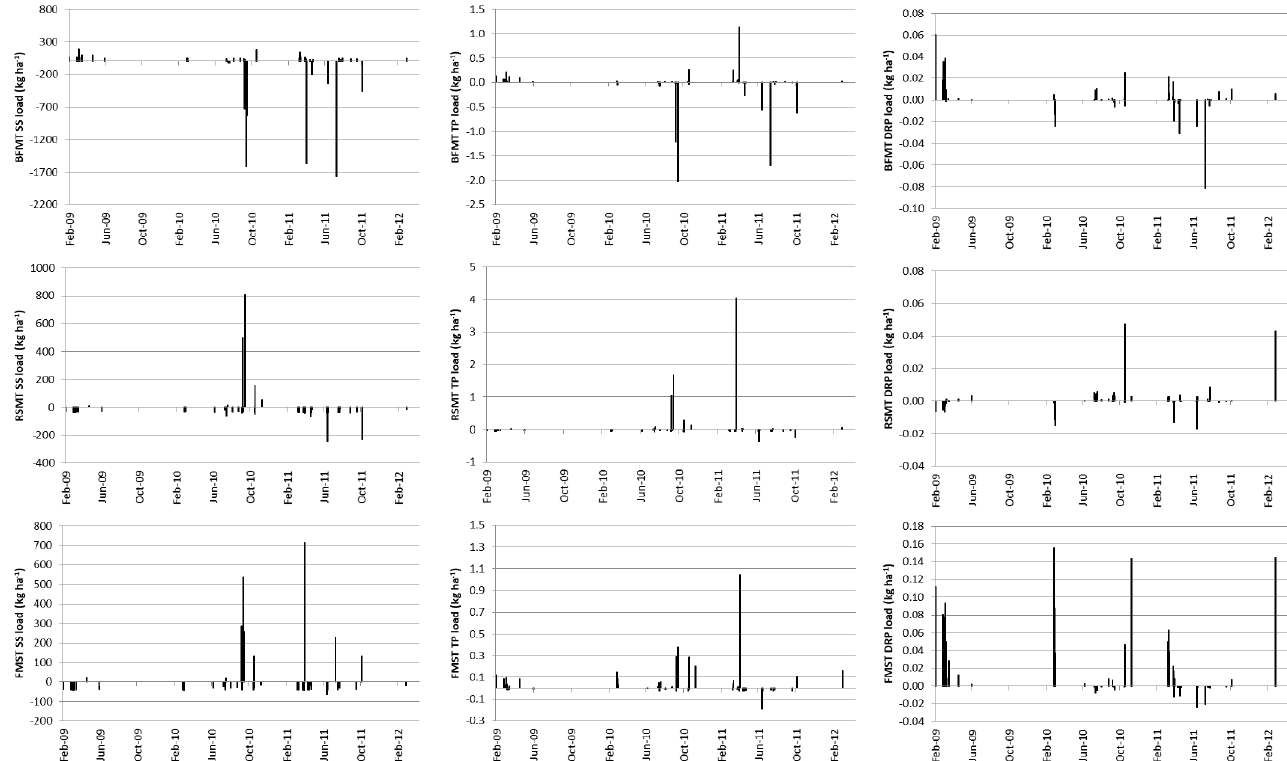
Figure 3. Observed minus predicted values for runoff events throughout the treatment period for each system BFMT = fall applied manure/chisel tillage with grass buffer ( top ); RSMT = fall rye (cover crop) with spring applied manure and chisel tillage ( center ); or FMST = fall applied manure with spring tillage ( bottom ) for suspended solid (SS) load (mg kg − 1 ) ( left ); total P (TP) load (mg kg − 1 ) ( middle ); and dissolved reactive P (DRP) load (mg kg − 1 ) ( right ).